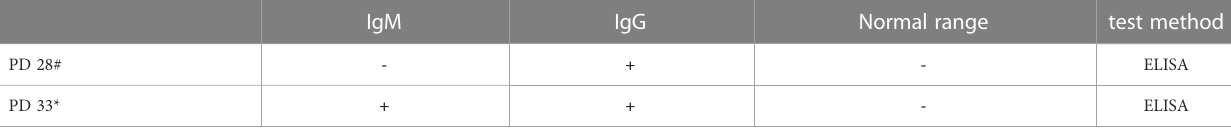
TABLE 2 The changes of IgM and IgG in serum. IgM IgG Normal range test method